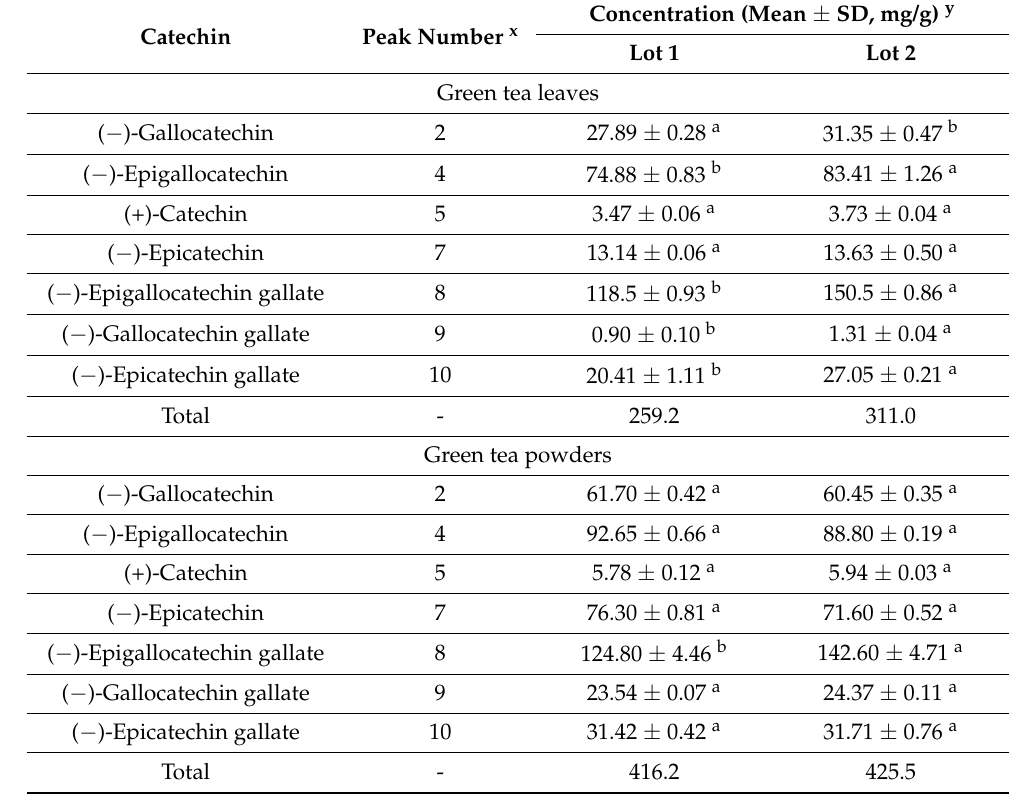
Table 5. Composition of catechin compounds in green tea leaves and